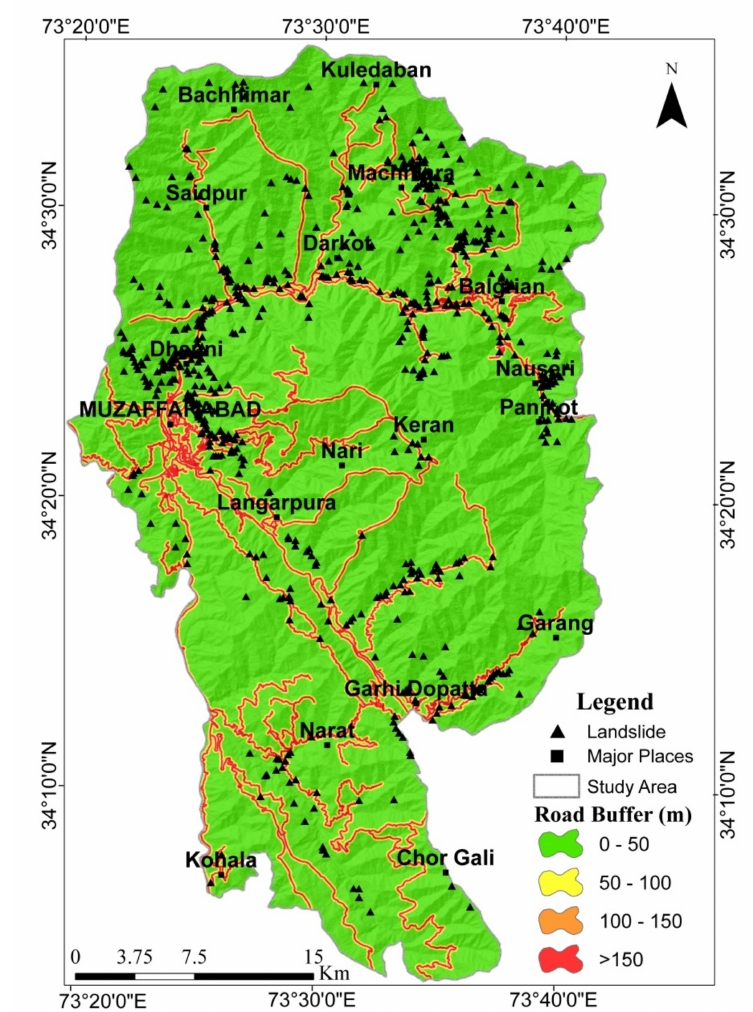
Figure 8. Road causative factor